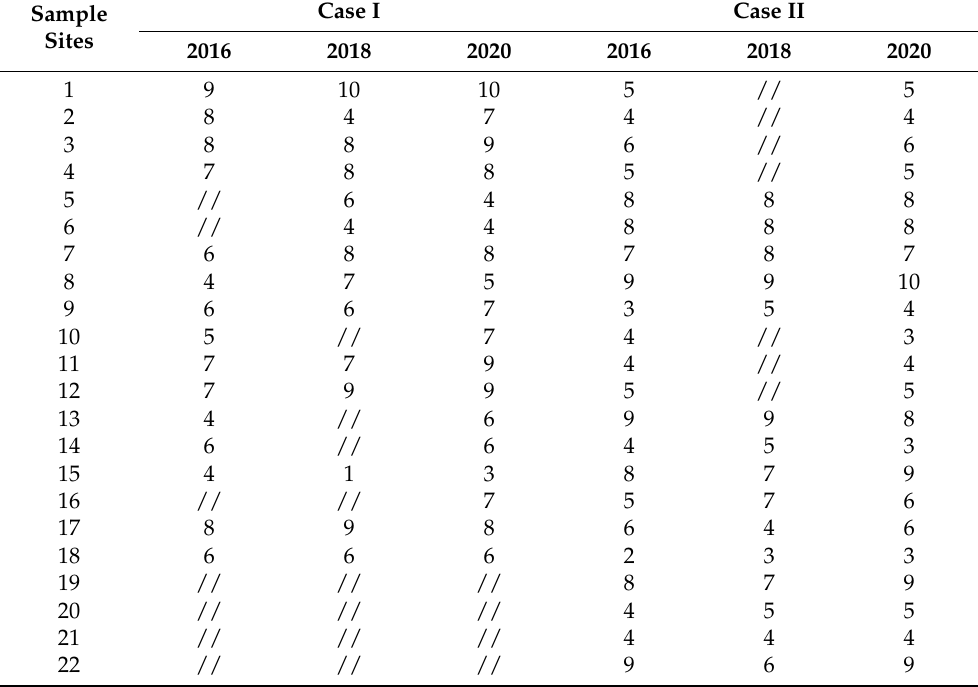
Table 4. Plant diversity grade of sample sites.